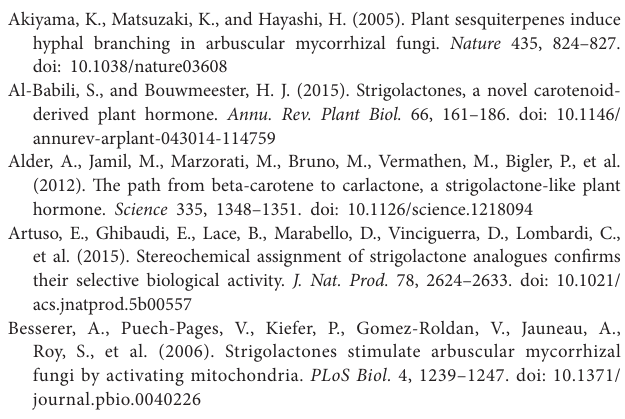
FIGURE S3 | Ligplot showing the residues of ShHTL7 forming close contacts with AR8 (A) and MP13 (B) , respectively. FIGURE S4 | Ligplot showing the residues of OsD14 forming close contacts with AR8 (A) and MP13 (B) , respectively. TABLE S1 | Weekly Striga hermonthica emergence in response to suicidal effect of formulated strigolactone analogs application in pots under green-house conditions. TABLE S2 | Physico-chemical properties of MP13 and